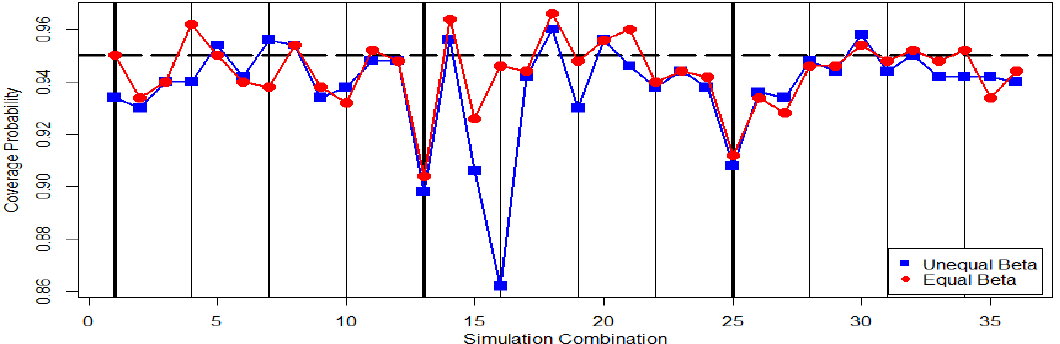
Figure 13. Comparison of coverage